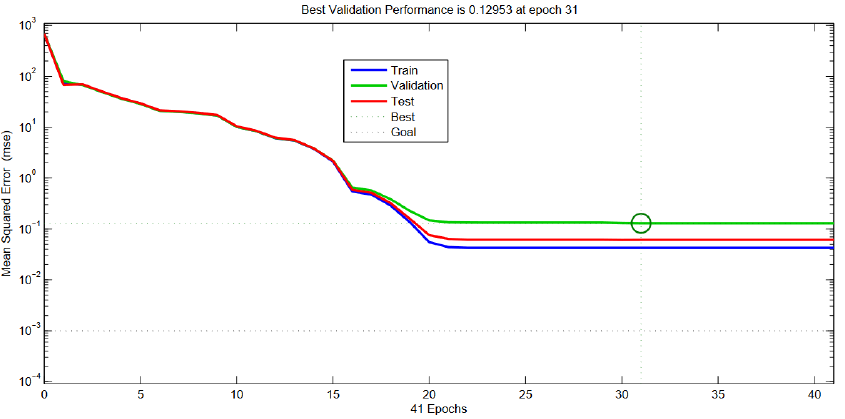
Figure 31. Evaluation of mean squared error (for the periodic array